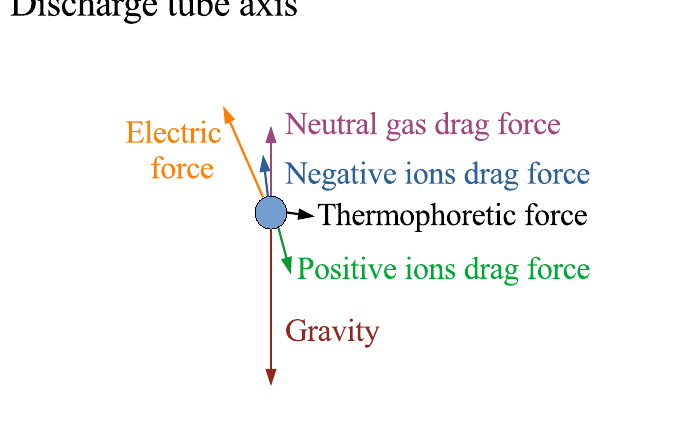
Figure 3. Sketch of principle forces (not to scale) acting on a single microparticle in an oxygen-doped discharge